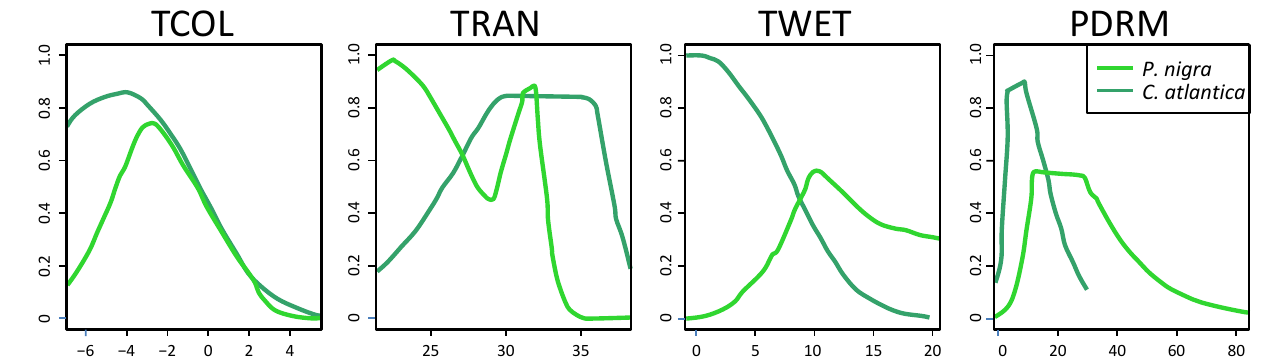
Figure A4. Response curves of the four environmental variables in the models in M AX E NT . The differences in the pattern of the curves between the Pinus nigra and Cedrus atlantica models are consistent with the divergences observed in the distribution of their habitats. TCOL, min temperature of coldest month, TRAN, temperature annual range, TWET, temperature of wettest quarter, PDRM, precipitation of driest